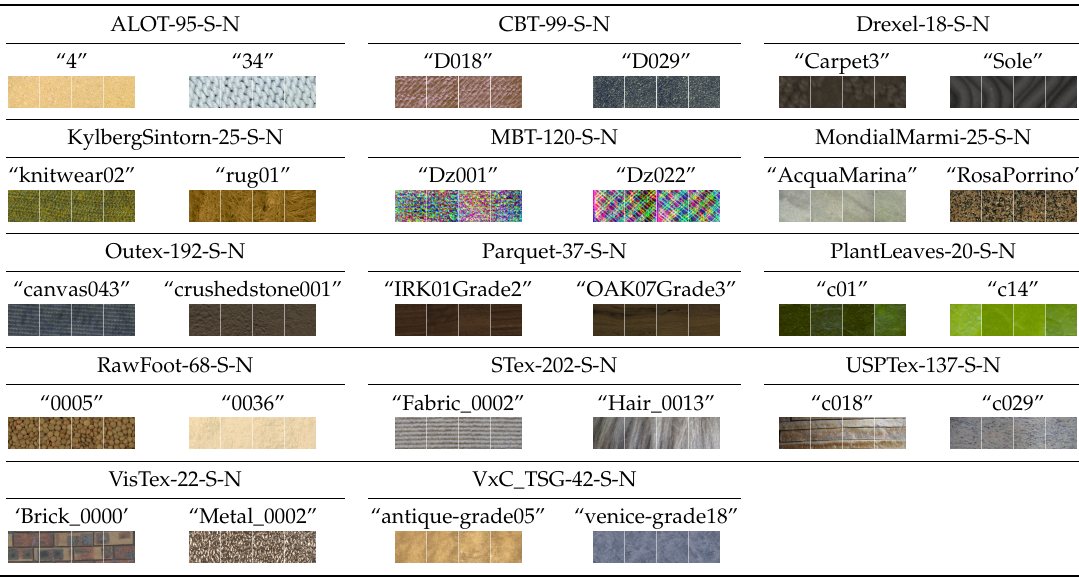
Figure 1. Group #1: Stationary textures acquired under steady imaging conditions (Section